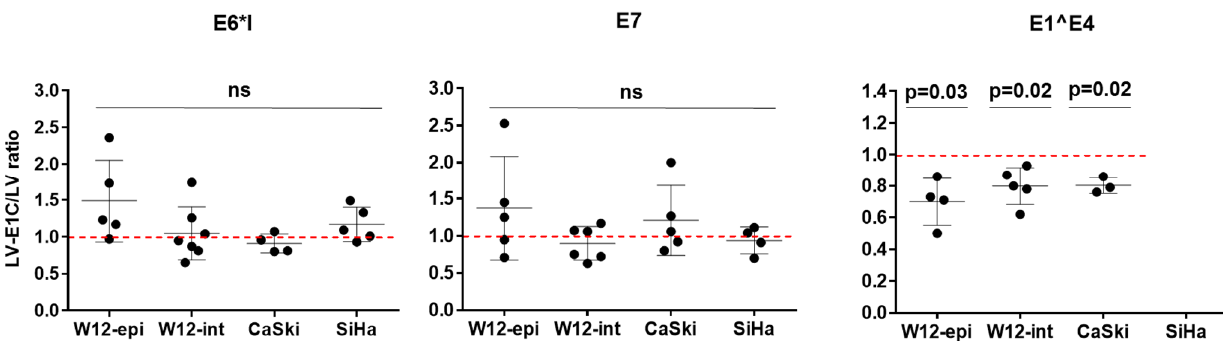
Figure 3. Effect of overexpression of HPV16 E1C on HPV16 transcripts. HPV16-positive cell lines W12-epi, W12-int, CaSki and SiHa were stably transduced with lentiviral vector expressing E1C (LV-E1C) or empty vector (LV) and HPV16 transcripts E6*I, E7, and E1ˆE4 were quantified. Ratios of transcript quantities in LV-E1C- to LV-transduced cells (LV-E1C/LV ratio) are shown on the y-axis. For reference, ratio 1.0 is indicated by red broken lines. Bars show mean with standard deviation from 3 to 7 independent experiments; ns—not significant, p —two-tailed p value from paired t test. Extreme outliers ( n = 15 of 108 total data points (14%)) defined as LV-E1C/LV ratios < 0.5 x median or >2.0 x median (Table S3) were excluded from this analysis.